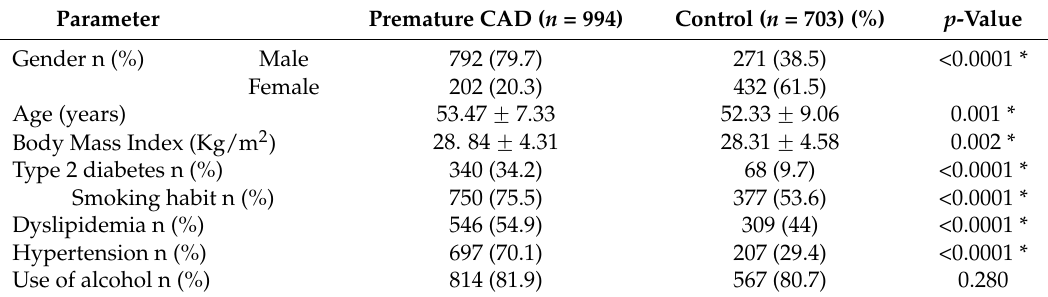
Table 1. Baseline clinical characteristics in patients with premature CAD and